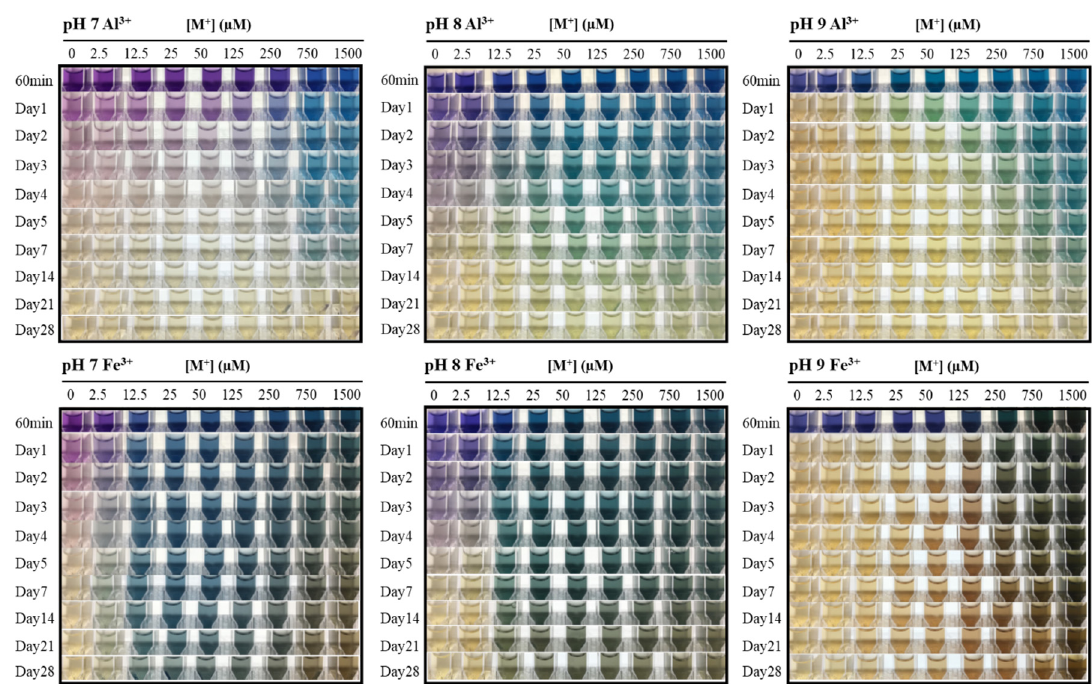
Figure 6. Color stability of purple potato anthocyanin metal chelates at pH 7–9 over 28 days. Samples were stored under refrigerated conditions in the dark.